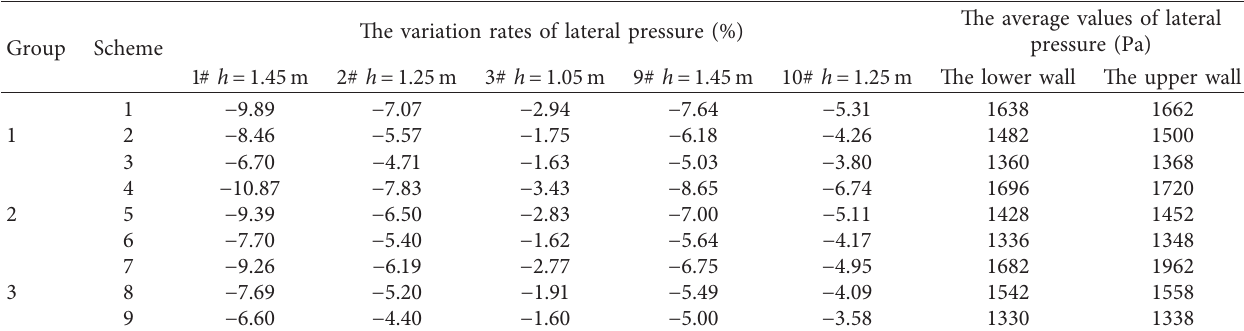
Table 8: The relationship between the granular grading and lateral pressure of reduction rates and average values. The variation rates of lateral pressure Group Scheme